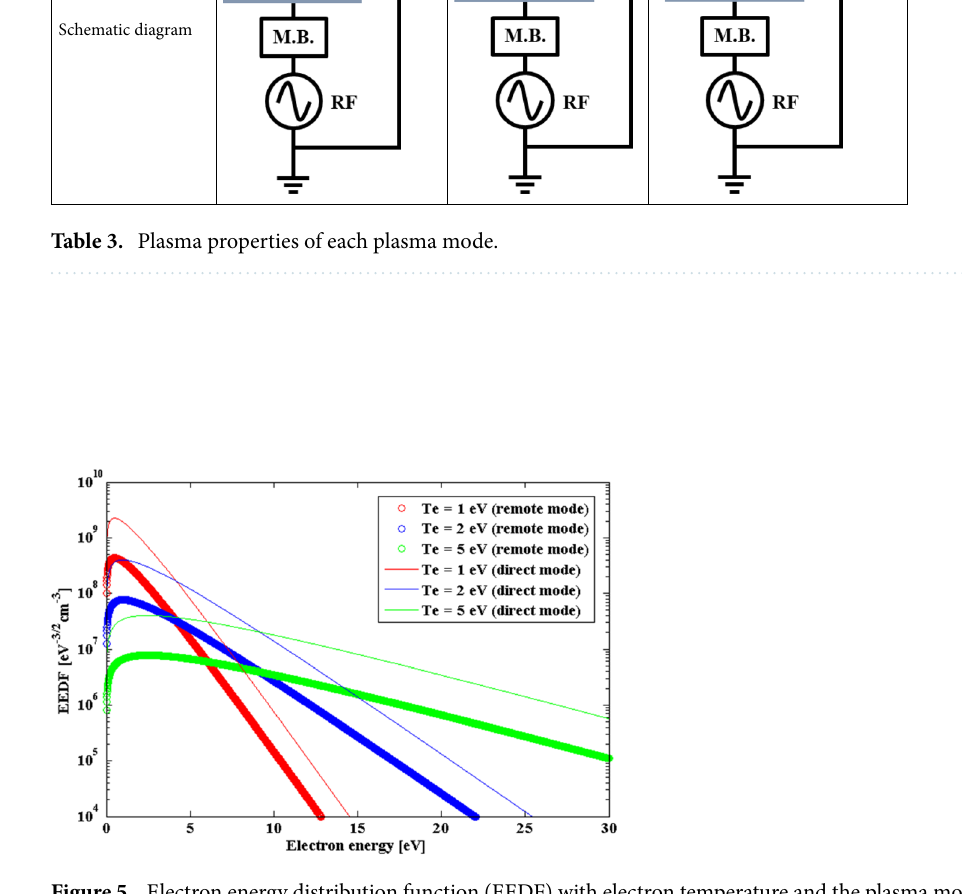
Figure 5. Electron energy distribution function (EEDF) with electron temperature and the plasma